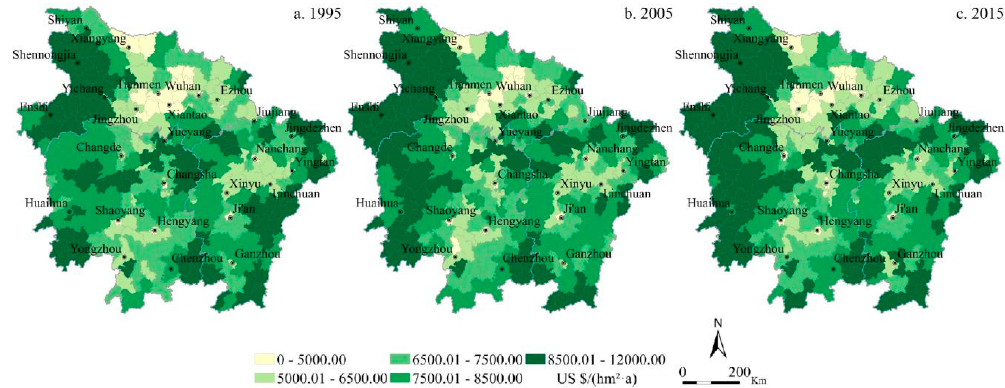
Figure 2. The spatial pattern of ecosystem services supply capacity in the MRYRUA from 1995 to 2015. ( a ) Ecosystem services supply capacity in 1995. ( b ) Ecosystem services supply capacity in 2005. ( c ) Ecosystem services supply capacity in 2015.